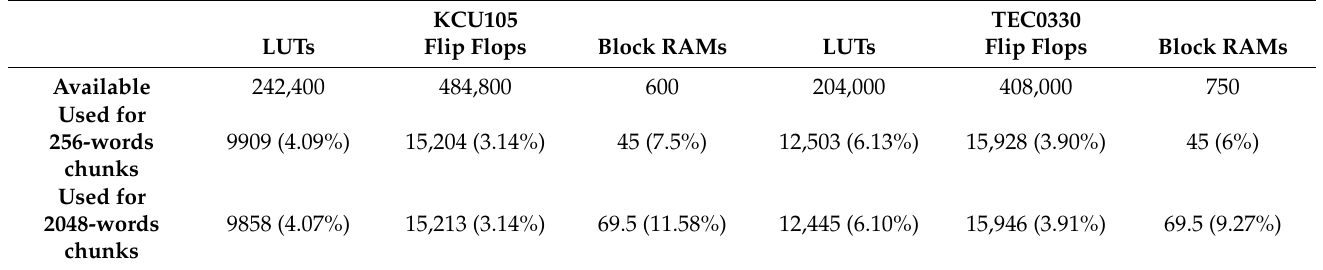
Table 1. Resource consumption of the DMA engine for tested hardware platforms and two lengths of the data chunks. Absolute and percentage (in parenthesis) consumption is given. The artificial data source was included in the design, but the ILA blocks used for debugging were excluded.